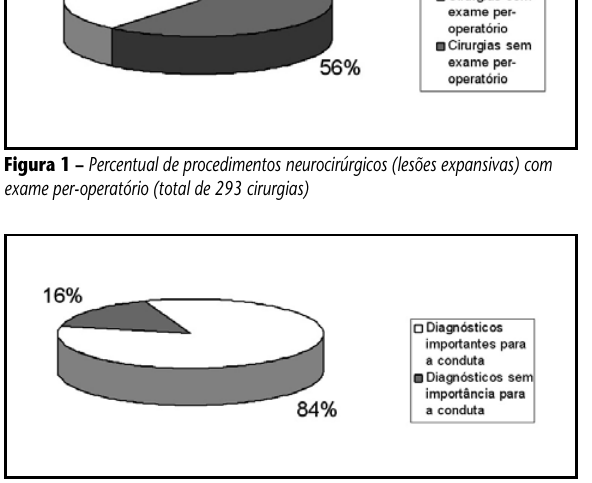
Figura 2 – Importância do diagnóstico per-operatório para a conduta neurocirúrgica imediata (total de 130 casos)